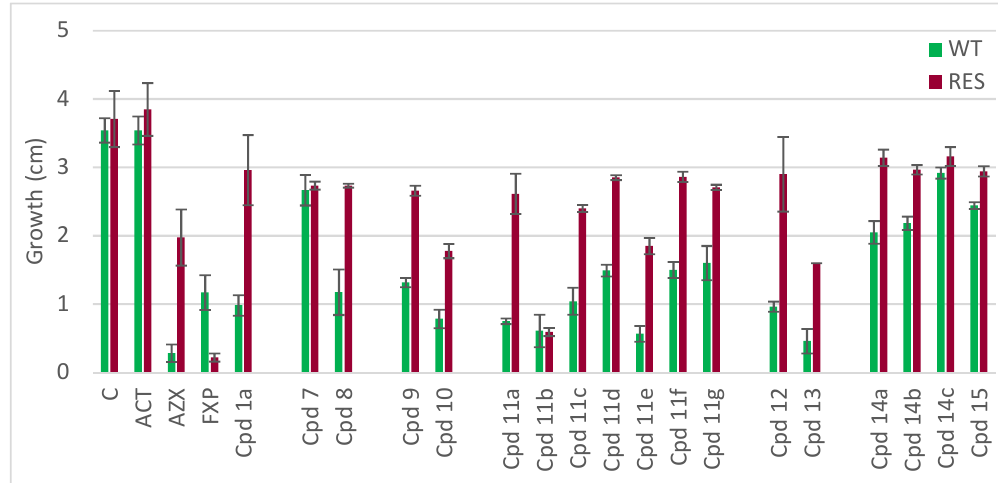
Figure 3. Mycelium growth of wild-type (WT) and QoI-resistant (RES) Pyricularia oryzae strains on control malt-extract agar media (C = control, ACT = 1% acetone) and media supplemented with azoxystrobin (AZX), fluxapyroxad (FXP), or dual compounds (Cpds 1a , 7–15 ) at a concentration of 25 mg/L. Error bars represent the standard deviation of the mean. Table 1. Inhibition of mycelium growth of wild-type (WT) and QoI-resistant (RES) Pyricularia oryzae (Scheme 1), acetone (ACT), and media supplemented with azoxystrobin (AZX), fluxapyroxad (FXP), or dual compounds (Cpds 1a , 7–15 ) at a concentration of 25